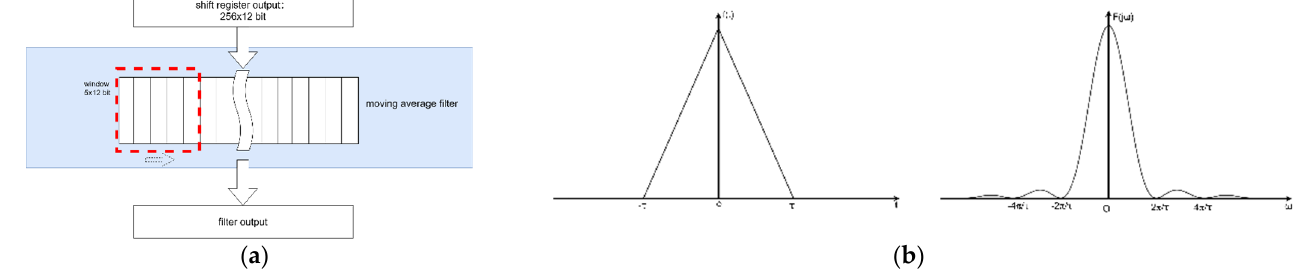
Figure 3. ( a ) Structure of the moving-average filter on FPGA. ( b ) Determination of the filter orders for the spectrum data using Fourier transformation.